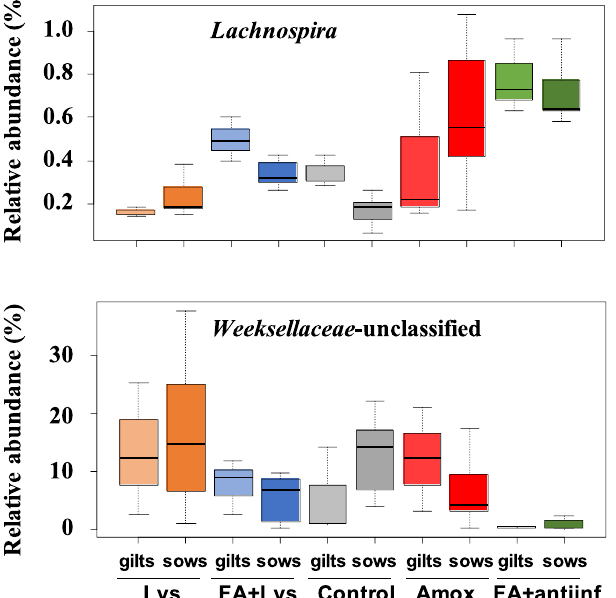
Figure 8. Analysis of composition of microbiomes (ANCOM) on nasal microbiota comparing groups considering the parity of the dams after treatment (D21). The ANCOM at genus level detected Lachnospira and an unclassified member from Weeksellaceae as differentially abundant. The mean relative abundance of these genera is shown in percentage. The dotted lines represent standard deviation and outliers are indicated with white circles. The treatment groups were: Lys lysozyme, FA + lys medium chain fatty acids and lysozyme, C control, with no additives, Amox amoxicillin, FA + antiinf medium chain fatty acids and a natural antiinflammatory; each group was splitted according the parity of their dams: gilts (first delivery) or sows (more than 1